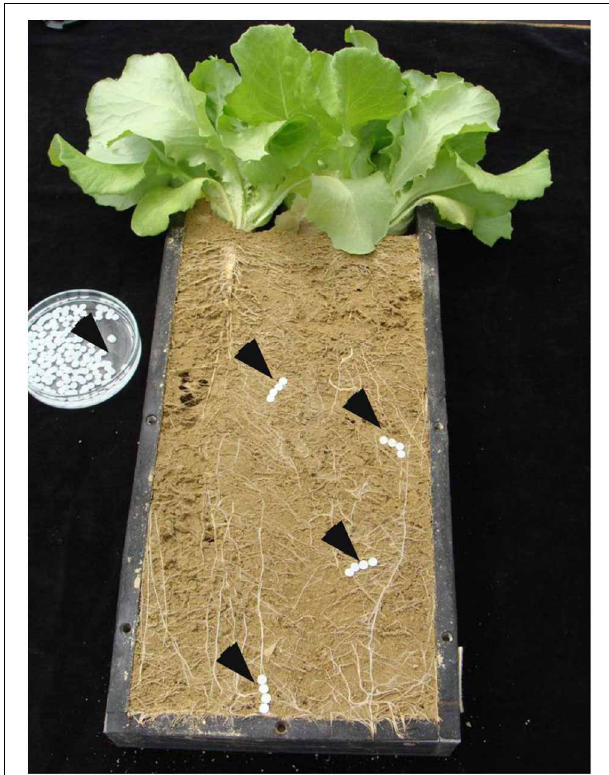
FIGURE 1 | Lettuce plants Lactuca sativa L. cv. Tizian (BBCH 19) grown on loess loam. Root observation window of a minirhizotron (rhizobox) prepared for exudate collection with sorption filters (indicated by black arrows).